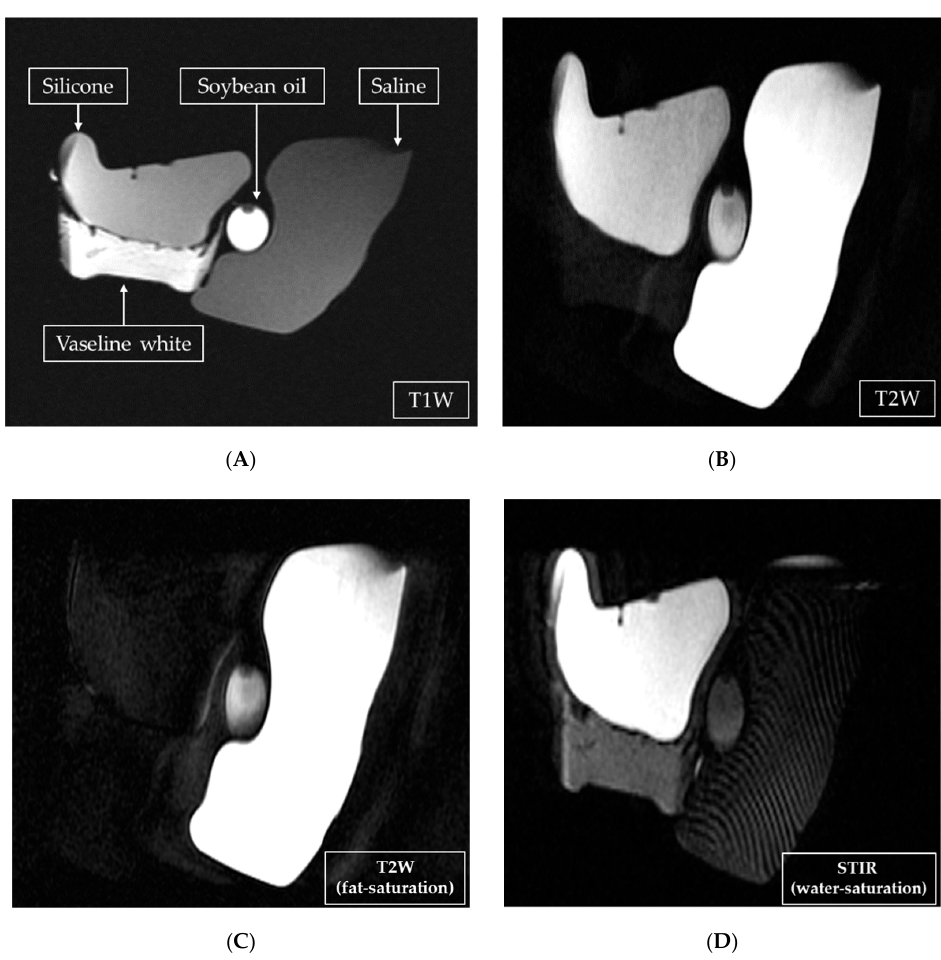
Figure 2. The MR images of three implants, one each of silicone, oil, and saline, using four MRI pulse sequences: ( A ) T1-weighted (T1W); ( B ) T2-weighted (T2W); ( C ) T2W fat-saturation; and ( D ) short-tau inversion recovery (STIR)